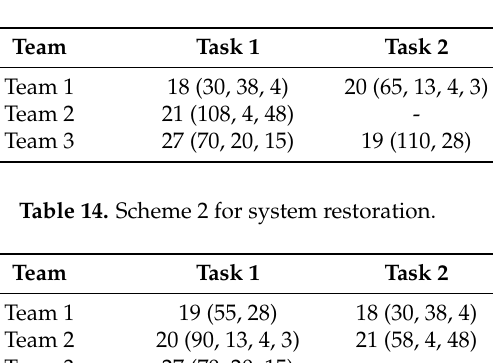
Table 13. Scheme 1 for system restoration.